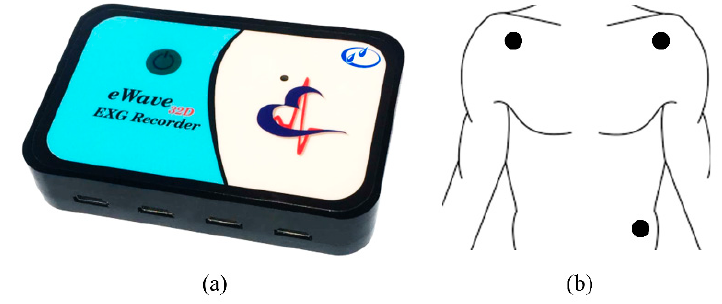
Figure 2. ( a ) Biomedical data acquisition device; ( b ) ECG lead placement.